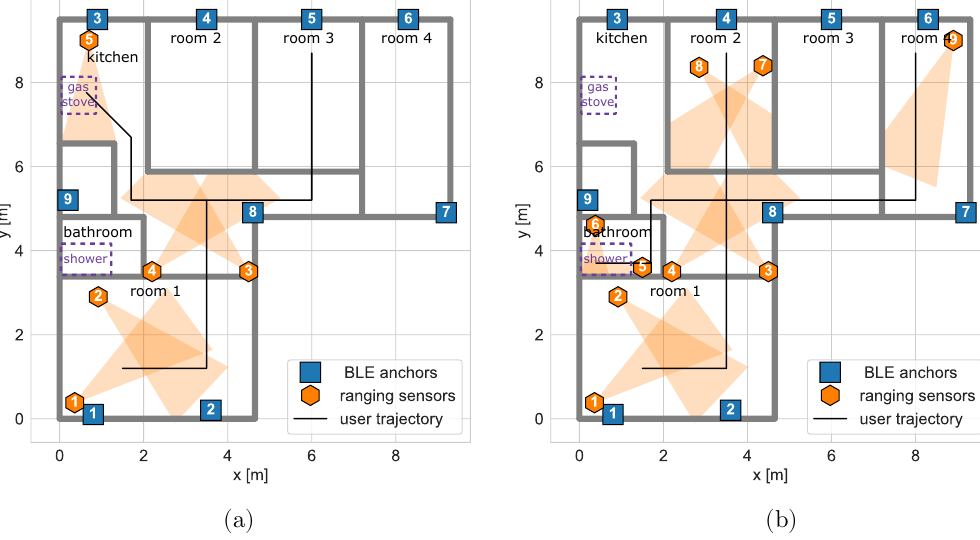
Figure 3. System layout and test paths used during the performed simulations. ( a ) scenario 1 ( b ) scenario